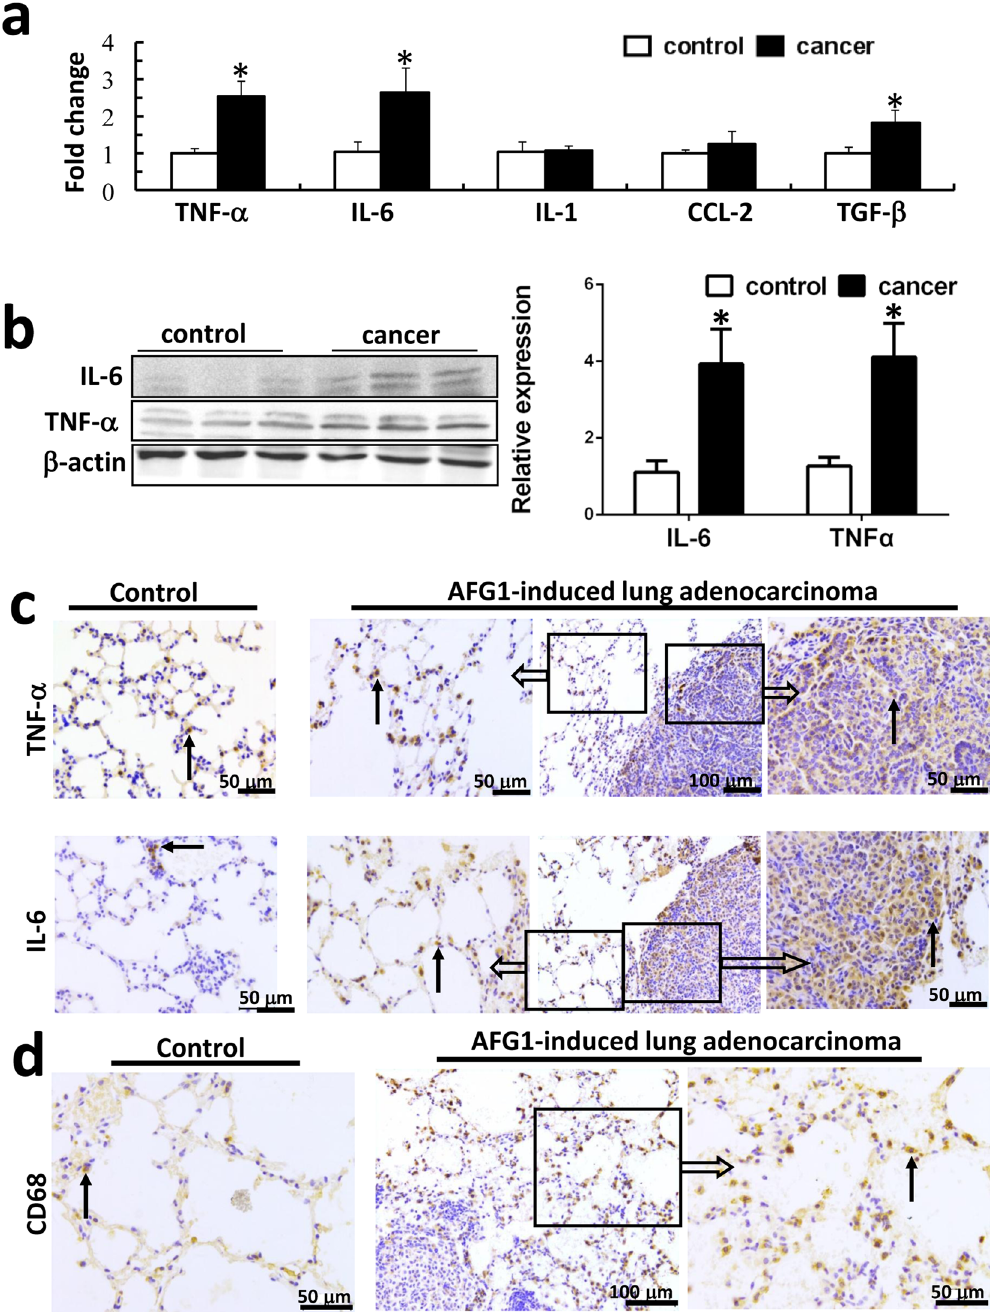
Figure 3. Tumor-associated inflammatory microenvironment is elicited in AFG 1 -induced lung adenocarcinoma. The RNA and protein samples as well as paraffin sections isolated from the lung- adenocarcinoma or control lung tissues were collected from our previous study. ( a ) Several cytokines and chemokines expression at mRNA level were determined by real-time PCR. Data was shown as mean ± SD (n = 4, * p < 0.05, compared to control group). ( b ) The expression of IL-6 and TNF- α at protein level was shown by Western blot. Band intensity is coming from densitometry, and data was shown as mean ± SD (n = 3, * p < 0.05, compared to control group). ( c ) Representative immunohistochemical staining of IL-6 and TNF- α in AFG 1 -induced lung adenocarcinoma. ( d ) Representative immunohistochemical staining of CD68 in lung tissues close to lung adenocarcinoma and control lung tissues. Black arrow points to positive